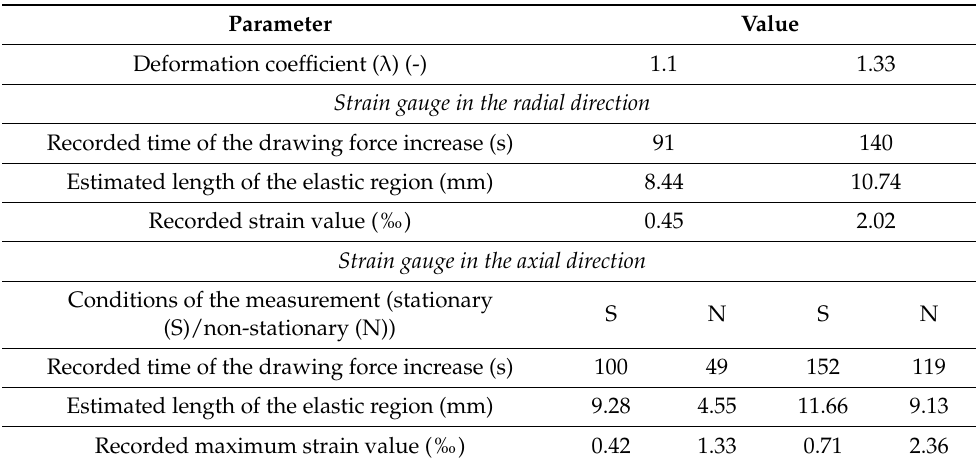
Table 6. Estimated lengths of the elastic deformation region-based strain gauge measurements (average values) during the wire drawing process with a velocity of 0.1 mm/s and deformation coefficients of 1.1 and